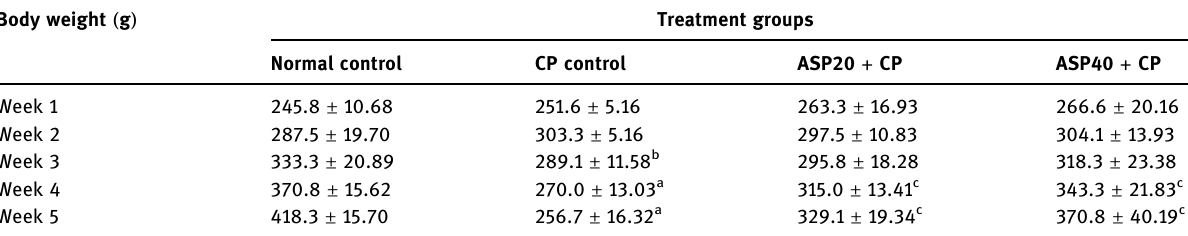
Table 1: E ff ect of ASP on body weight in CP - treated rats Body weight ( g